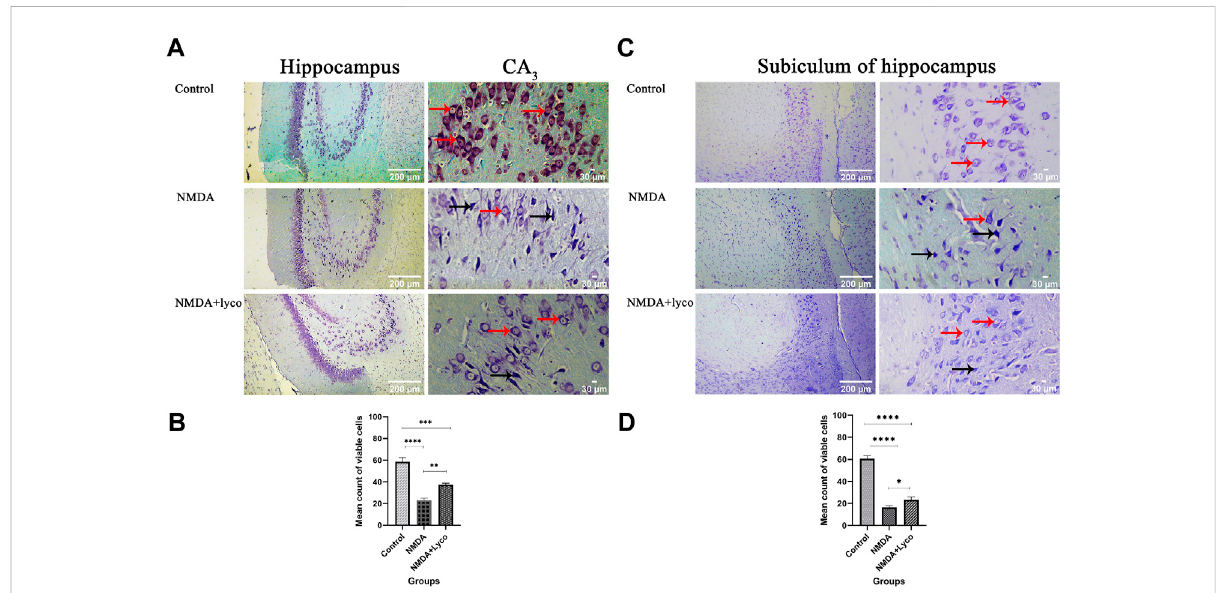
FIGURE 5 TheCresylVioletStainingofrathippocampus. (A) Thehealthy(Narrowredarrow)anddead(Narrowblackarrow)pyramidalneuronsareindicate intheCA 3 area. (B) TheeffectoftreatmentwithOLG1eonthemeancountofviablecellsinCA3ofthehippocampus.Thedataareshownasmeans± SEM of three rats per group (* p < 0.05 and ** p < 0.01 and *** p < 0.001 and **** p < 0.0001). (C) The healthy (Narrow red arrow) and dead (Narrow black arrow) pyramidal neurons are indicate in the subiculum area. (D) The effect of treatment with OLG1e on the mean count of viable cells in subiculum of the hippocampus. The data are shown as means ± SEM of three rats per group (* p < 0.05 and ** p < 0.01 and *** p < 0.001 and **** p <